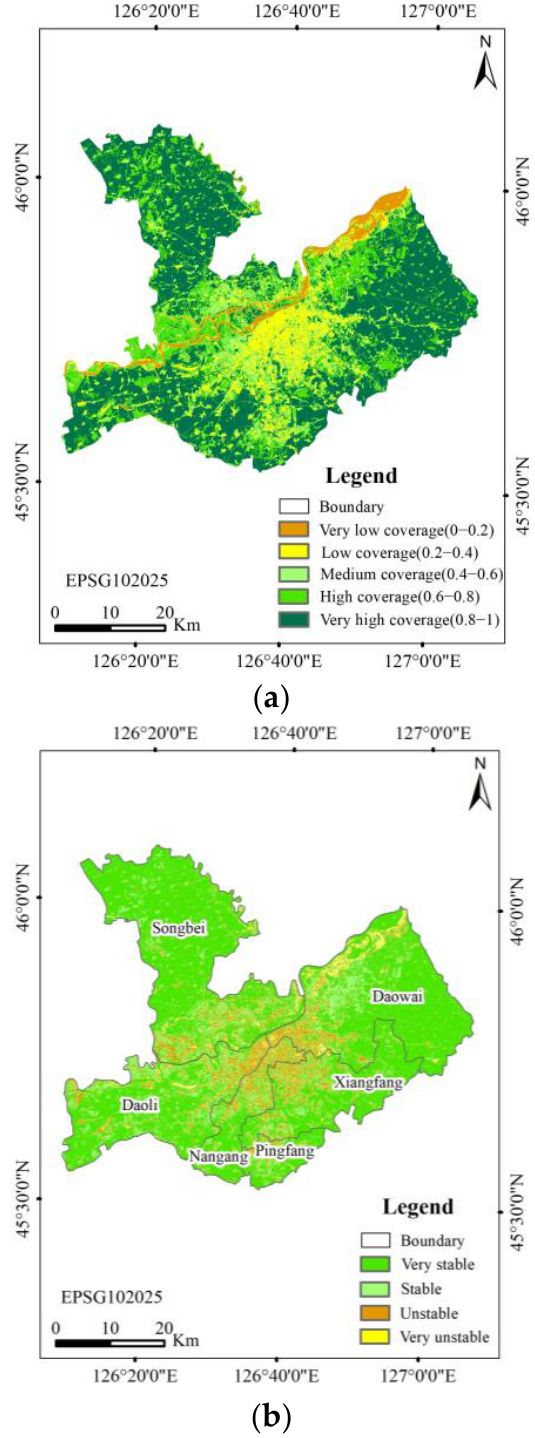
Figure 7. The average values ( a ) and coefficient of variations ( b ) for vegetation coverage in Harbin from 2004 to 2020.